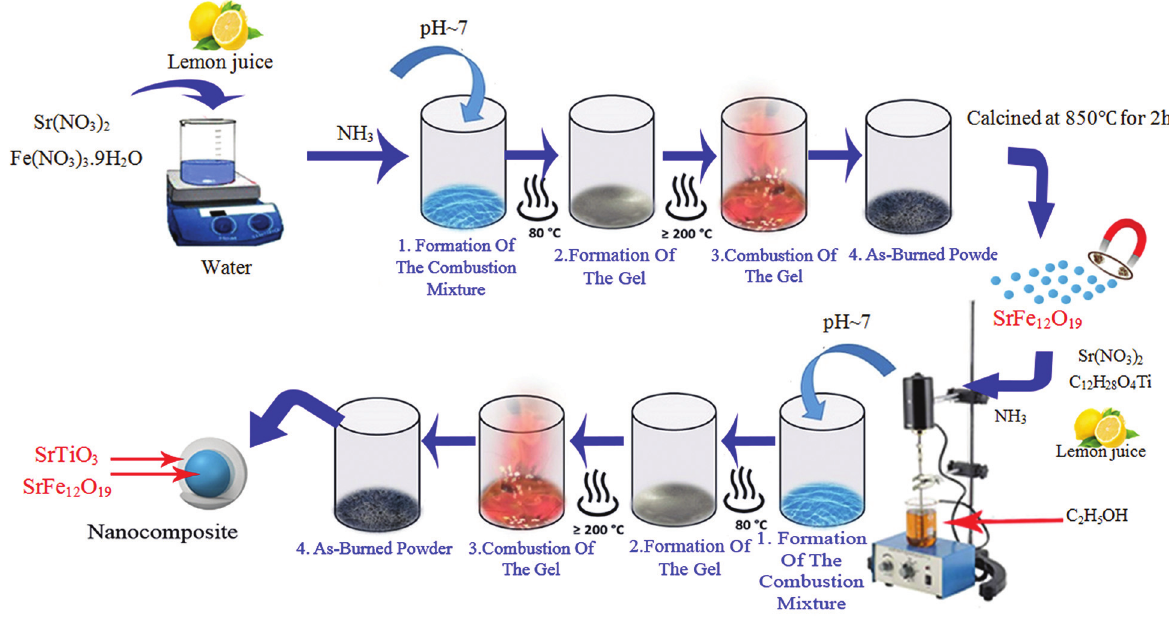
Figure 1: Schematic of nanoparticle SrFe